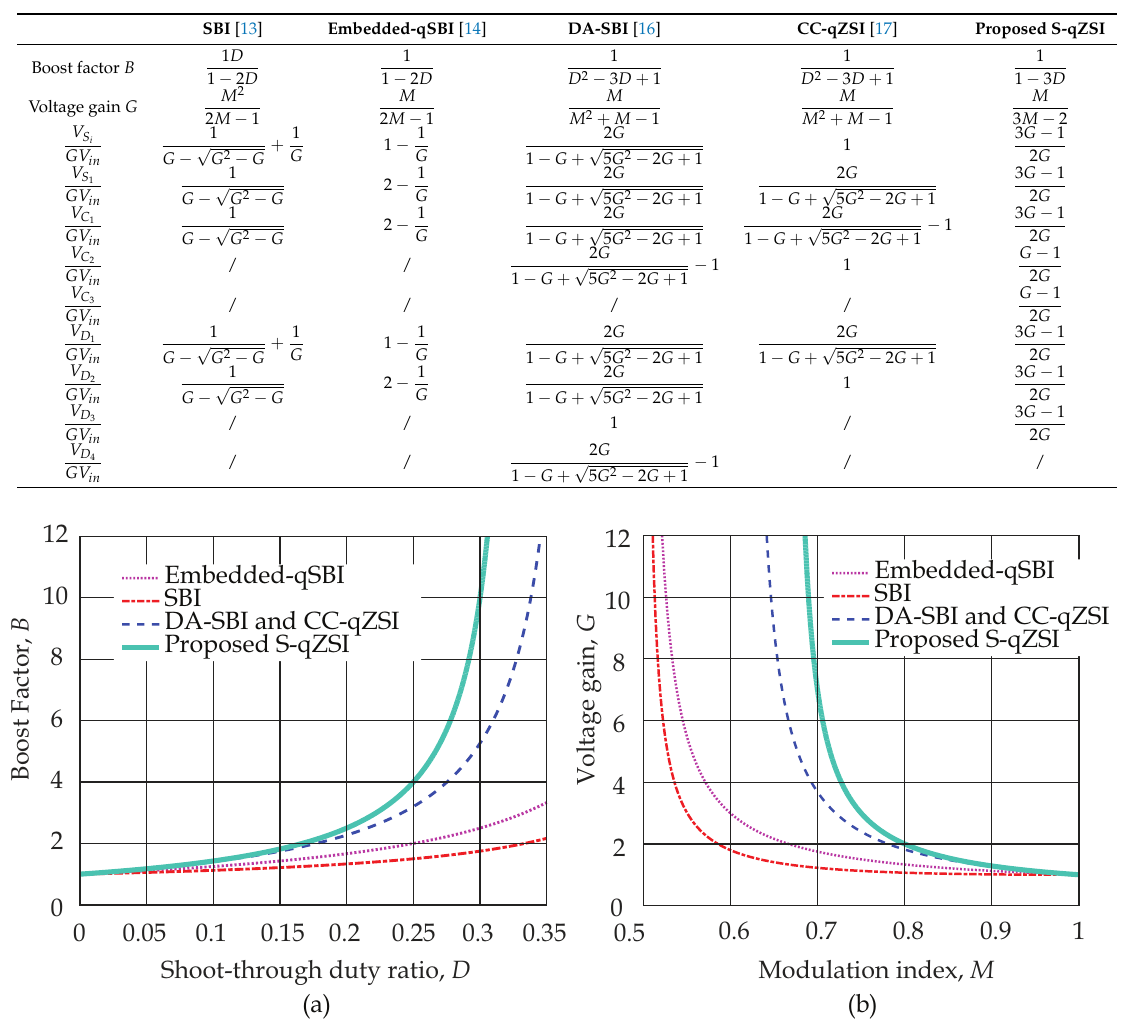
Figure 7. Comparative analysis: ( a ) comparison of the boost factor versus the shoot through duty ratio D among the selected topologies, and ( b ) comparison of the voltage gain versus the modulation index M among the selected